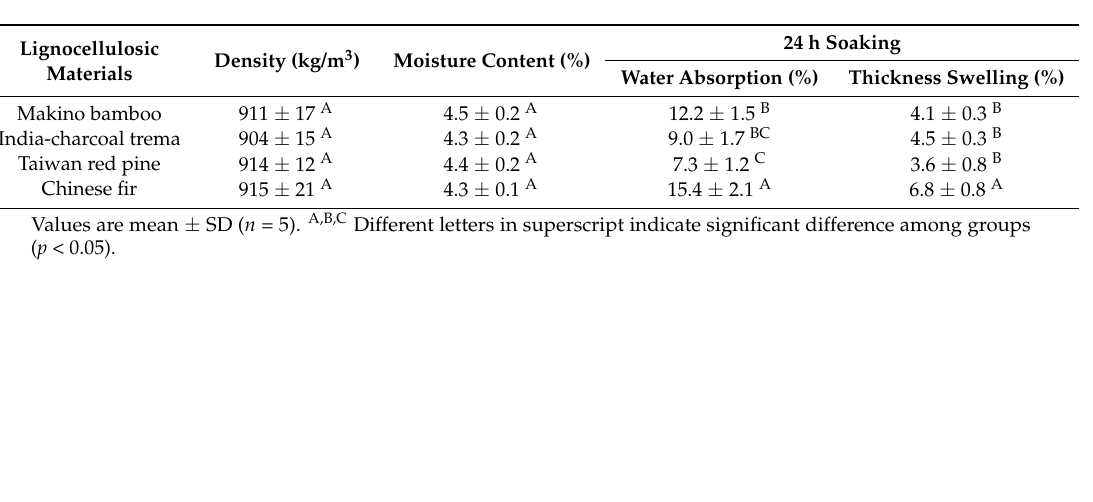
Table 2. The physical properties of WPCs made with different lignocellulosic